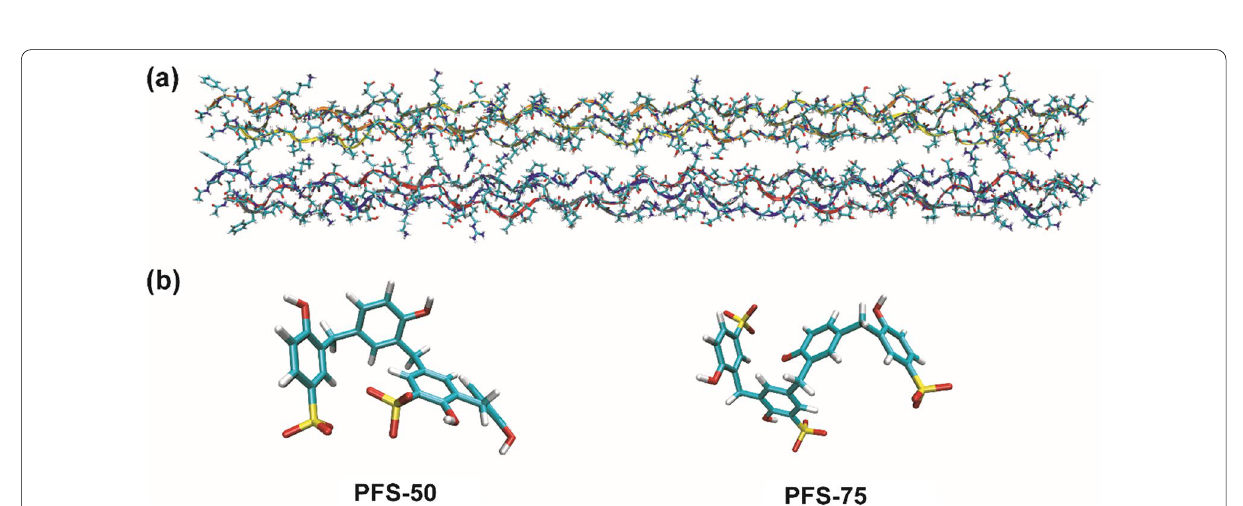
Fig. 1 Structure of a COL and b PFS‑50 and